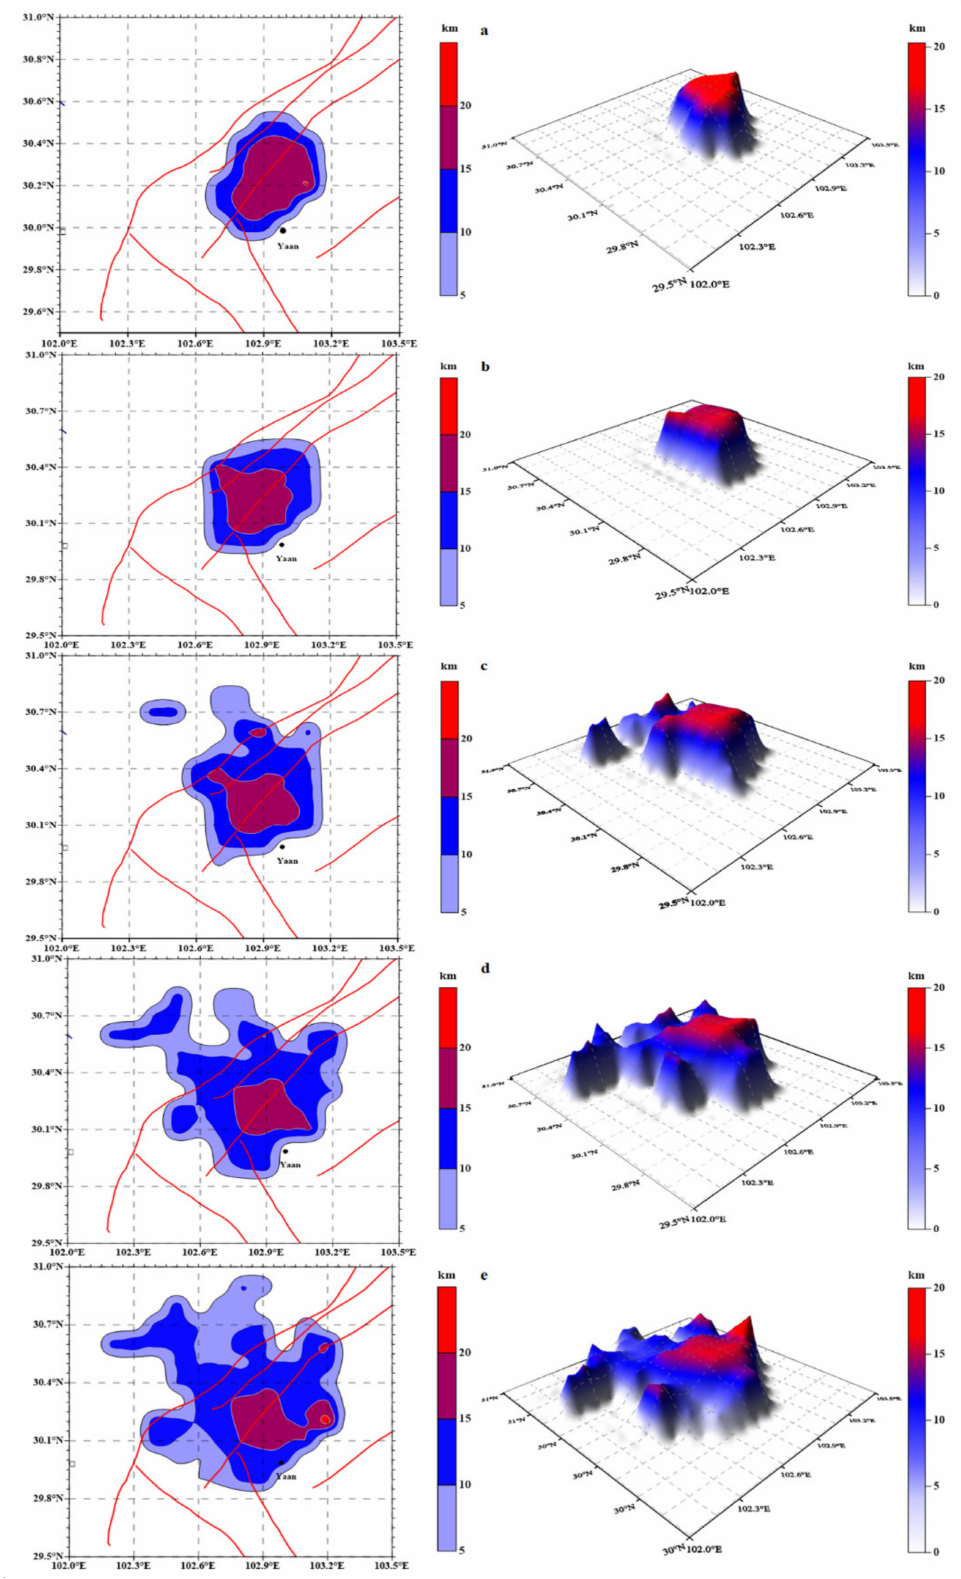
Figure 7. Spatial distribution of the focal depths of the aftershocks following the Lushan M S 7.0 earthquake on the fault plane. Red lines represent the locations of faults. ( a ) One day after the mainshock; ( b ) 1 month after the mainshock; ( c ) 5 months after the mainshock; ( d ) 10 months after the mainshock; and ( e ) 2 years after the